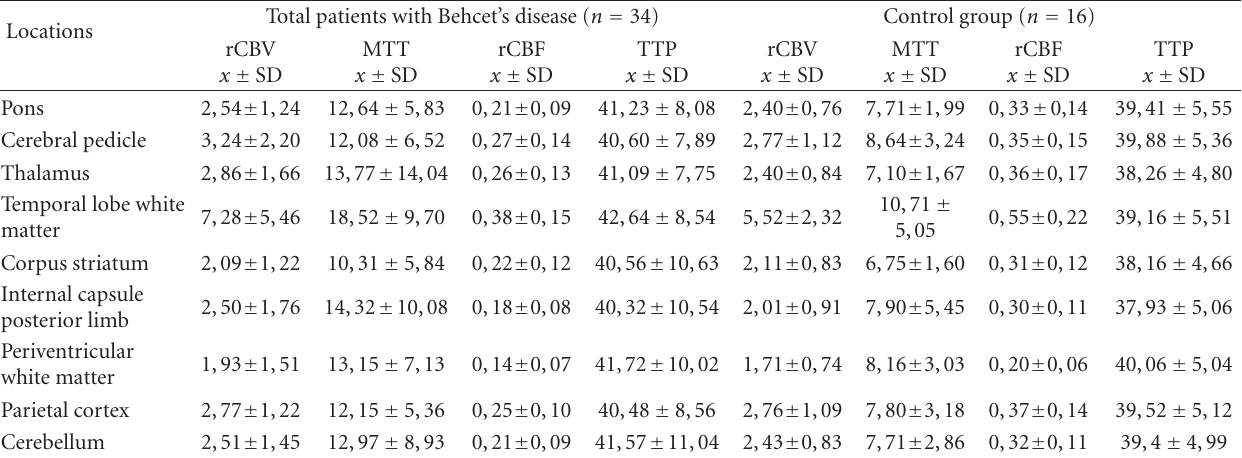
Table 1: Perfusion parameter values of all Behcet’s patients and control group.